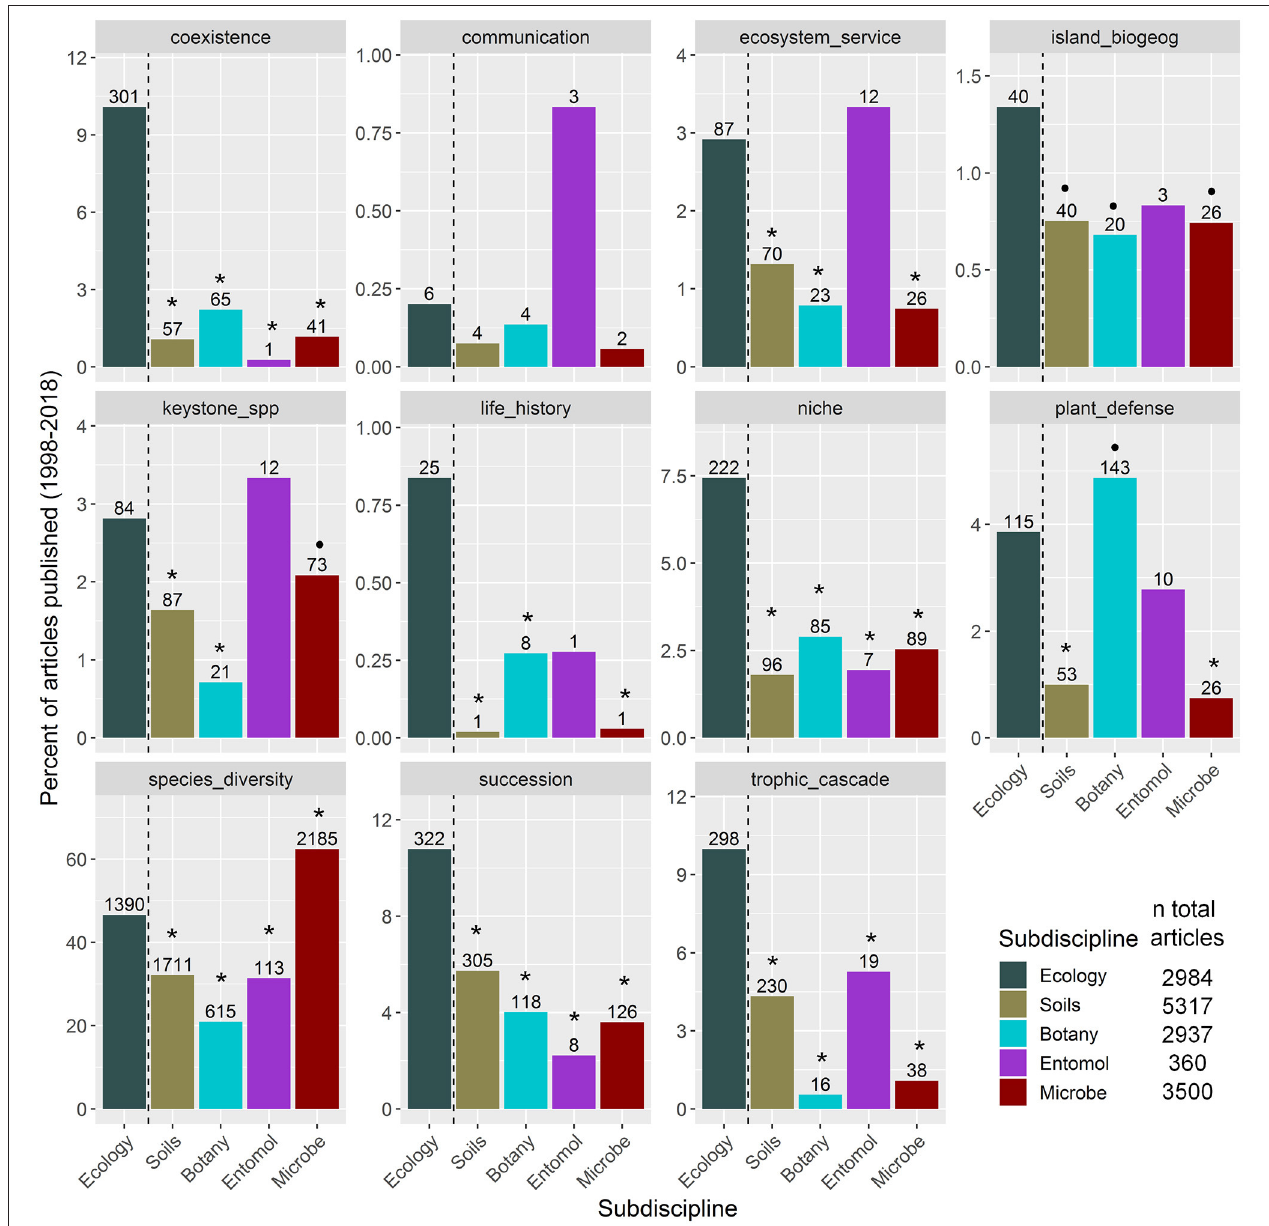
FIGURE 1 | Results of a literature search (1998–2018) for how frequently ecological concept keywords appear in articles that investigated rhizosphere interactions published in general ecology journals by subdiscipline journals. Bars represent the percent of articles related to each concept by subdiscipline. Numbers above the bars indicate the number of articles studying rhizosphere interactions within that subdiscipline that reference the concept, while the total number of articles that investigated rhizosphere interactions per subdiscipline is listed in the key. Subdisciplines that significantly differed in the percent of articles published compared to ecology journals based on pairwise proportion tests, corrected for family-wise error rates, are indicated as follows: • P < 0.1; * P <